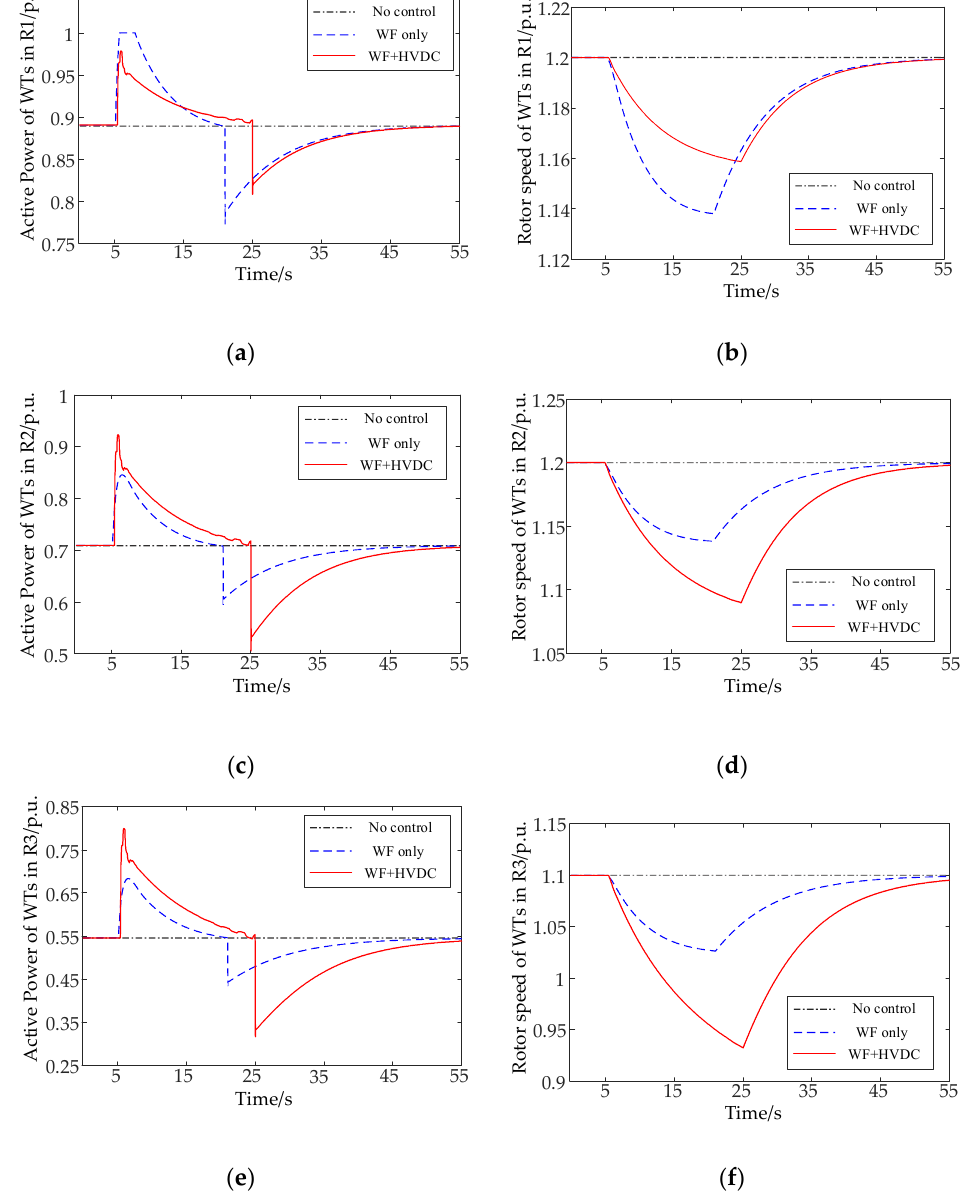
Figure 14. Active power and rotor speed of WTs in each subarea. ( a ) Active power of WTs in R1, ( b ) rotor speed of WTs in R1, ( c ) active power of WTs in R2, ( d ) rotor speed of WTs in R2, ( e ) active power of WTs in R3, and ( f ) rotor speed of WTs in R3. Table 5. Simulation results under high wind power permeability and high wind speed conditions. Strategies